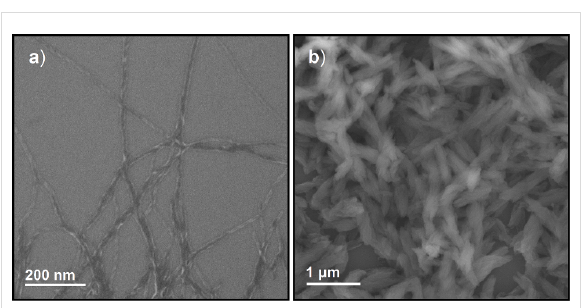
Figure 4: FESEM image of (a) 1 obtained from 40% aqueous NMP, (b) 2 obtained from 80% aqueous NMP.